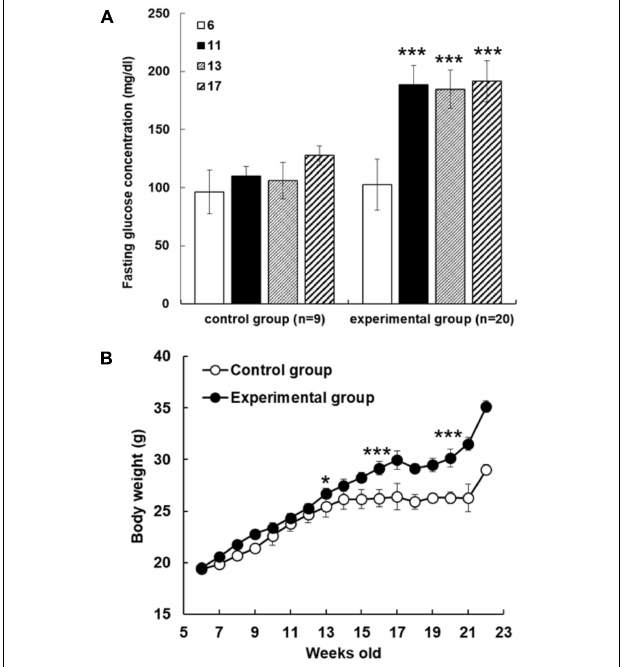
FIGURE 1 | Fructose-induced hyperglycemia affects fasting glucose concentrations and body weight. (A) The mice were assigned randomly to control and experimental groups at 6 weeks of age. Fructose-induced hyperglycemia was conducted for 16 weeks before AFE experiment. Fasting blood glucose concentration was measured at different time points as indicated (6, 11, 13, and 17 weeks of age). Concentrations of fasting blood glucose were higher in fructose-induced hyperglycemic mice than those in non-hyperglycemic mice. Numbers of independent studies ( n = 20), ∗∗∗ p < 0.001, as compared with paralleled untreated controls ( n = 9). (B) Body weights were measured periodically for the control group and fructose-feeding group for 16 weeks. The resulted body weight changes showed that mice in experimental group became obese after being fed with high fructose water for 2 months. The significant difference was shown at 13 weeks age, ∗ p < 0.05, and after then ∗∗∗ p < 0.001 as compared to control